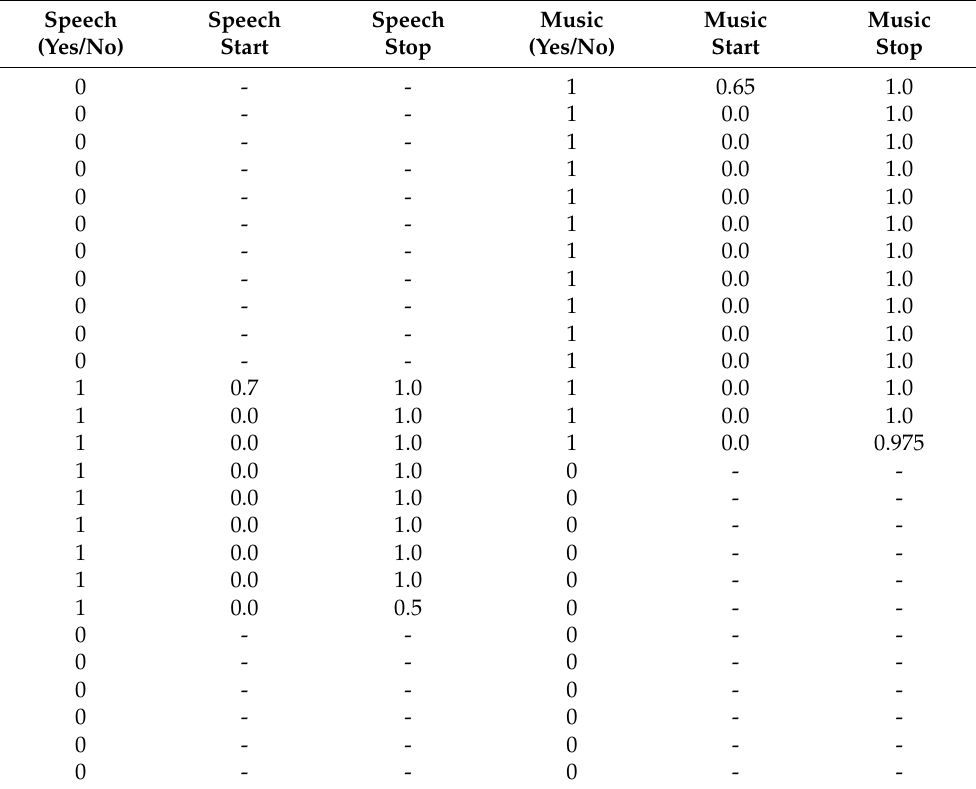
Table 2. An example of labels for the YOHO algorithm. Music occurs from 0.2 to 4.3 s and Speech occurs from 3.6 to 6.0 s. Note that start and stop values are considered only when the respective audio class is present. The dimensions of the output are 26 × 6. Note that each time step/row in the table corresponds to 0.307 s. The start and stop values are normalised on the range of 0 to 1. For instance, in the first time step, music’s start point would be rescaled from 0.2 to